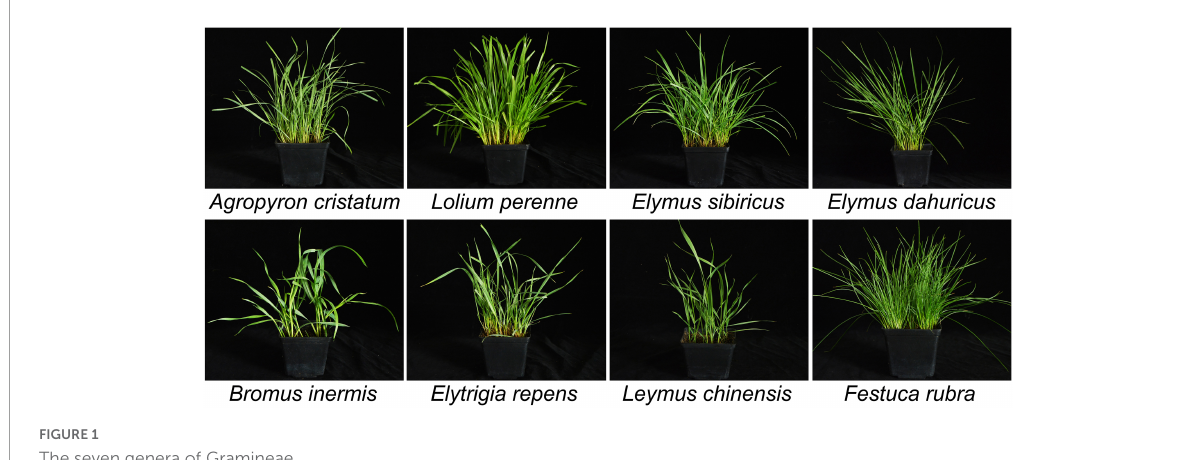
FIGURE1 The seven genera of Gramineae.